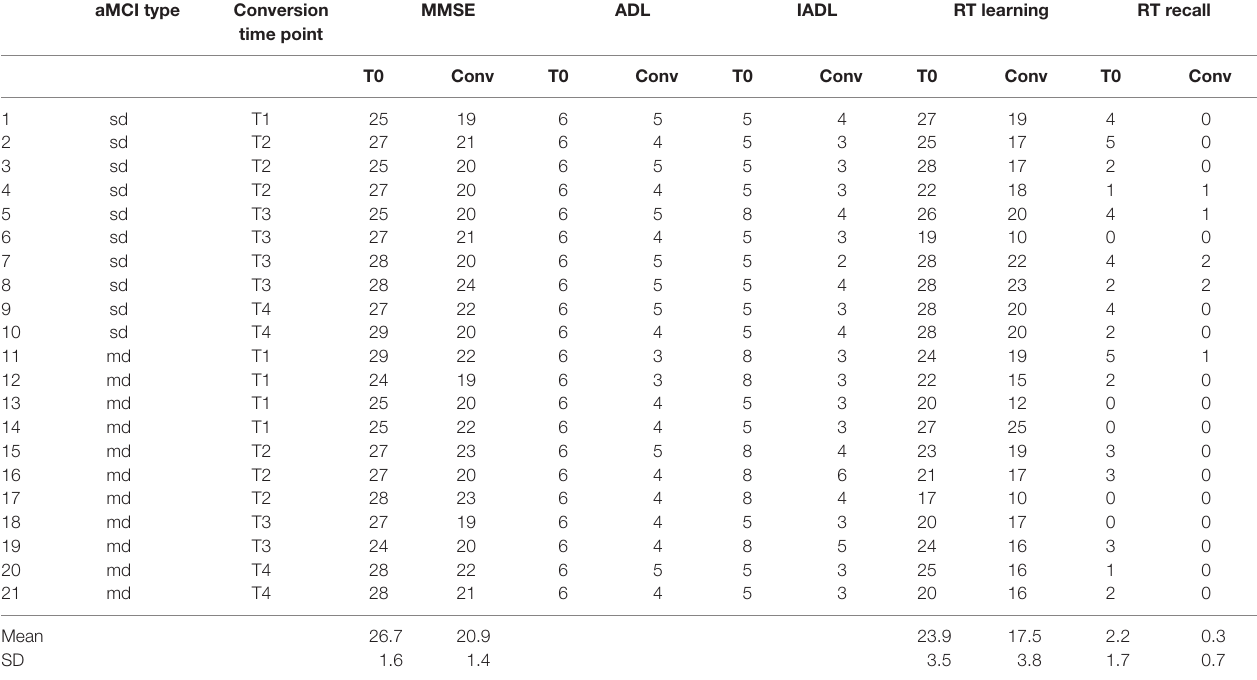
TaBle 2 | converters’ MMse, aDl, iaDl, and rT scores obtained at baseline (T0) and at the time point of conversion